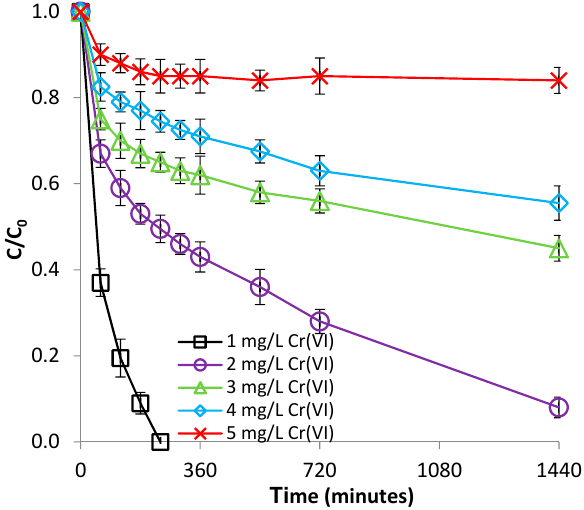
Figure 9. Effect of Cr(VI) concentration on Cr(VI) removal by Be-Fe(0).